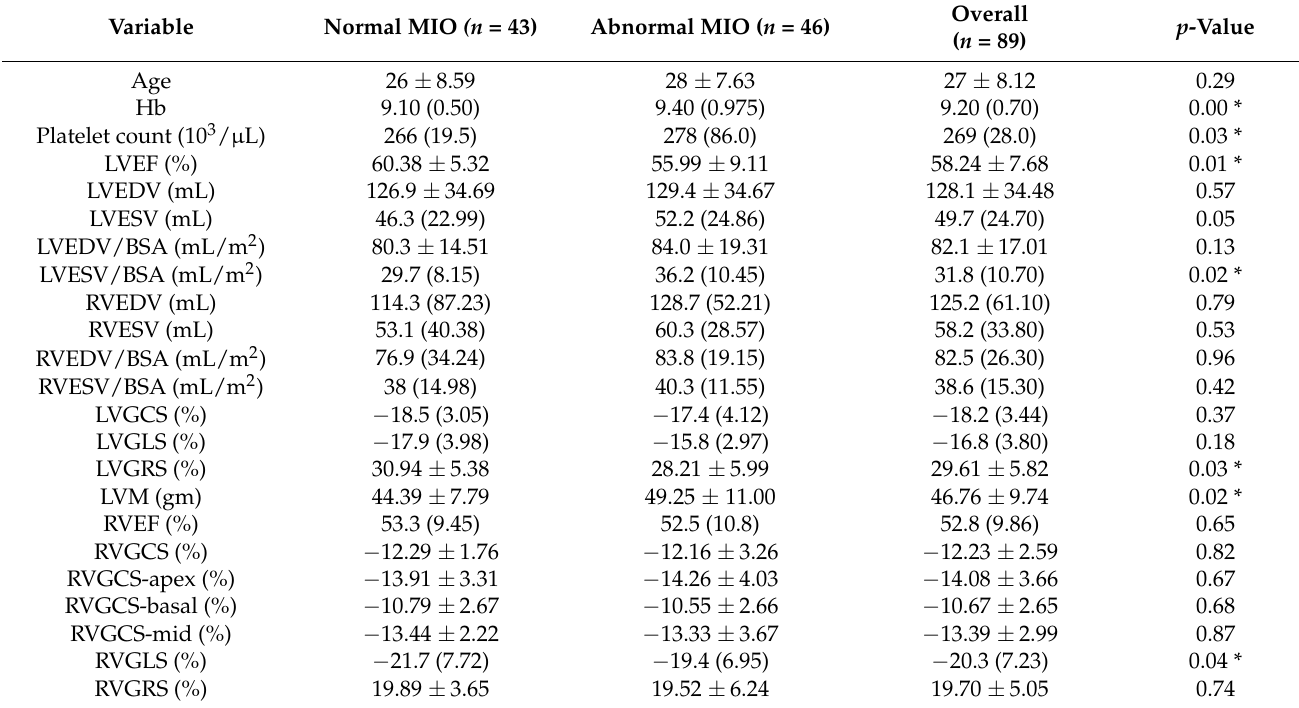
Table 1. Comparison of baseline characteristics in normal and abnormal MIO